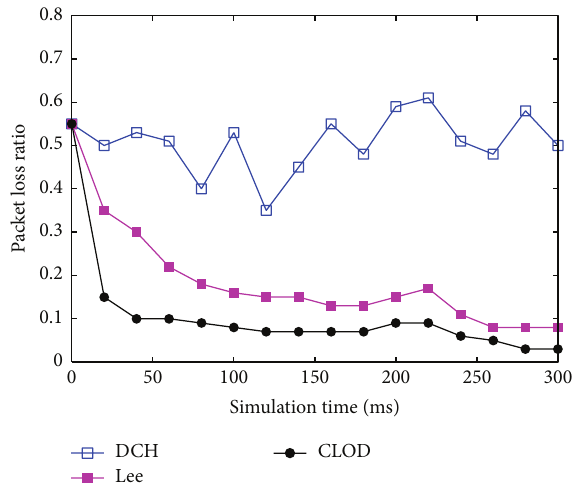
Figure 2: Comparison of dropped packet. Figure 3: Comparison of throughput.